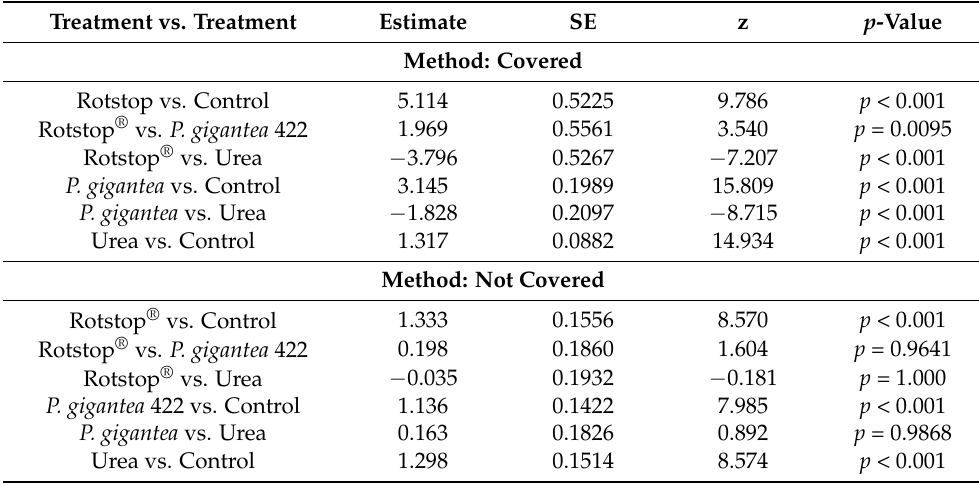
Table A1. Output of statistical tests reflecting relative Heterobasidion infected area, colonies per cm 2 . Relative infected area, Family = Poisson, Factors = Method + Treatment.